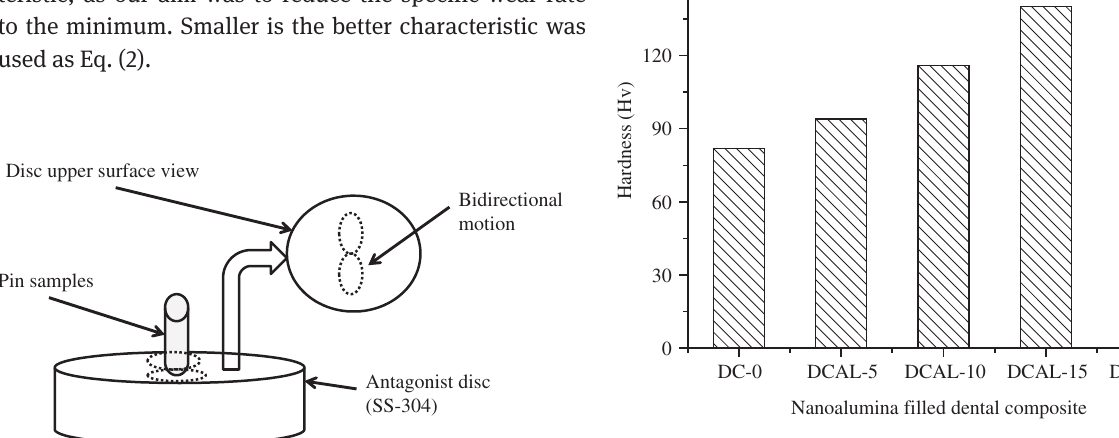
Figure 2: Effect of Vickers hardness on the nanoalumina-filled dental